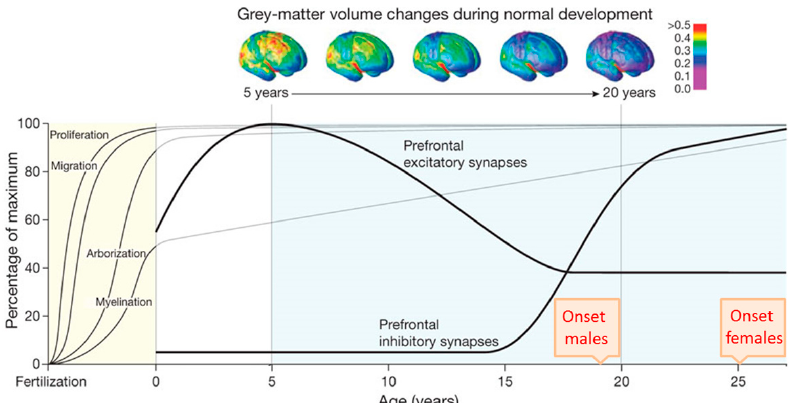
Figure 2. Temporal course of selected neurodevelopmental processes. The x axis depicts time from fertilization to young adulthood and the y axis shows the relative percentage of the maximum. The average age of schizophrenia (SCZ) onset in males and females in late adolescence and early adulthood, respectively, is indicated. Neurogenesis and subsequent migration of neurons to the cortex begin within a few weeks of gestation in humans and is completed around birth. Dendritic arborization and myelination continue postnatally towards adolescence and beyond. The progressive reduction of grey-mater volume detected with longitudinal neuroimaging (top) is thought to result from the combined effect of pruning of the neural arbor and myelin deposition. The formation of prefrontal excitatory synapses reaches a maximum in childhood at five years and declines thereafter until adolescence. By contrast, the formation of prefrontal inhibitory synapses strongly increases from 15 years onward through adolescence and levels off in early adulthood. Deregulation of the cortical excitatory-inhibitory balance is hypothesized to contribute to the development and manifestation of SCZ. Adapted from Thomas R. Insel, Rethinking Schizophrenia, published by Nature, 2010.